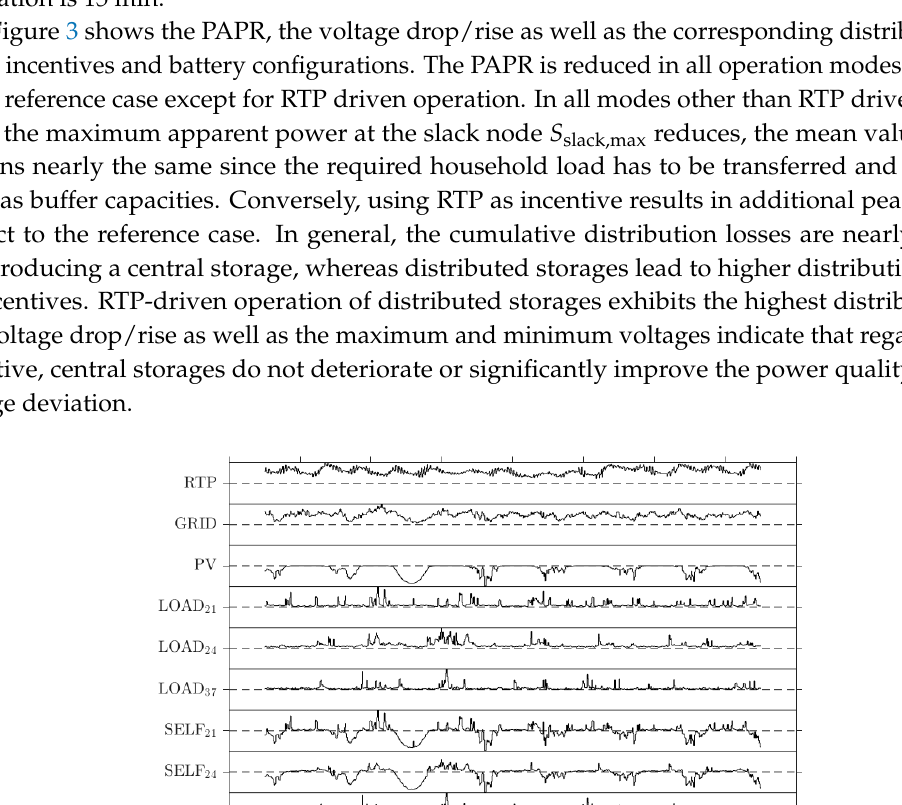
Figure 3. Peak-to-average power ratio, voltages and cumulative distribution losses for all configurations for a single, central storage (c) and multiple, distributed storages (d). The superscript